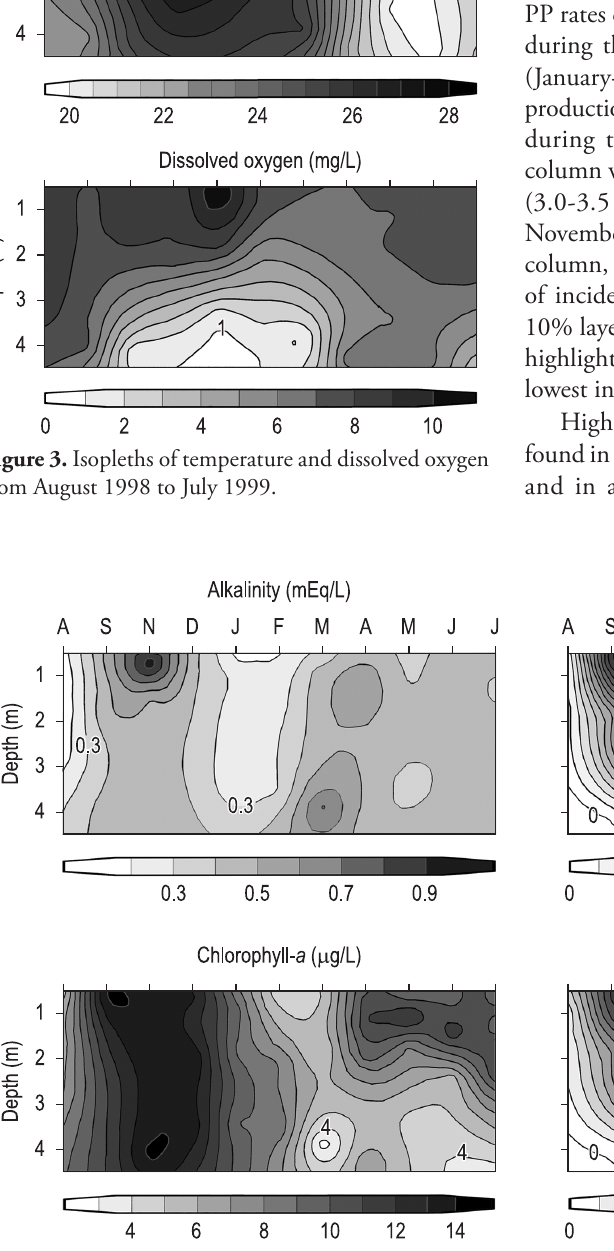
Figure 4. Isopleths of primary productivity rates, chlorophyll- a concentrations, assimilation rates, and alkalinity, from August 1998 to July